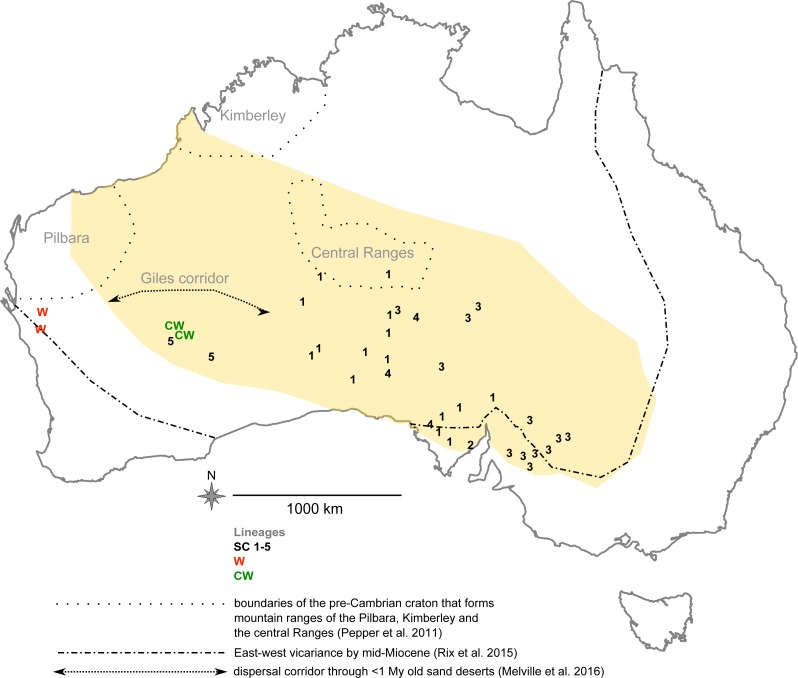
Urodacus yaschenkoi sampling locations across its distribution range (in dark yellow, adapted from Koch, 1977).Numbers 1 to 5 designate individuals belonging to the sub-lineages (SC1-5) of the south-central major clade (SC); members of the central-western (CW) clade and western (W) clades are marked in green and red color, respectively. Different hypotheses about diversification in various Australian taxa (vicariance, refugia, dispersal corridors) are adapted from Melville et al. (2016), Pepper et al. (2011) and Rix et al. (2015).